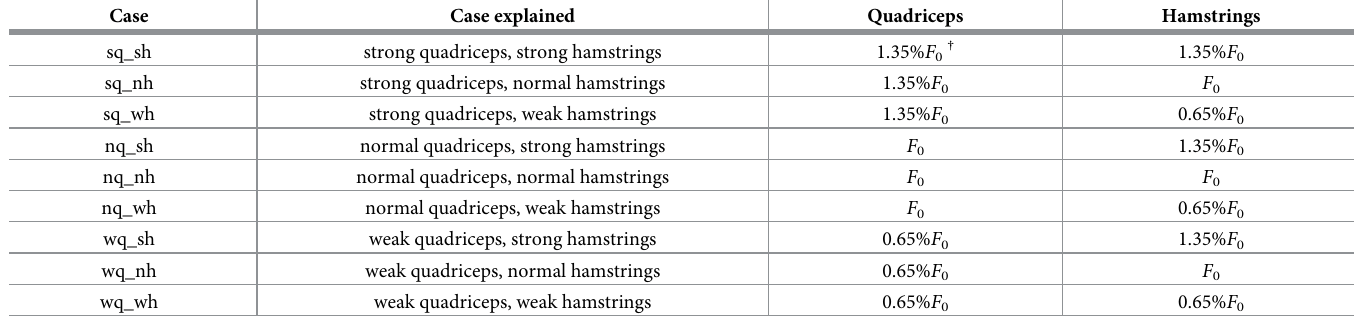
Table 9. Demonstration of the nine cases with different combinations of normal, weak and strong quadricep and hamstring muscles. Case